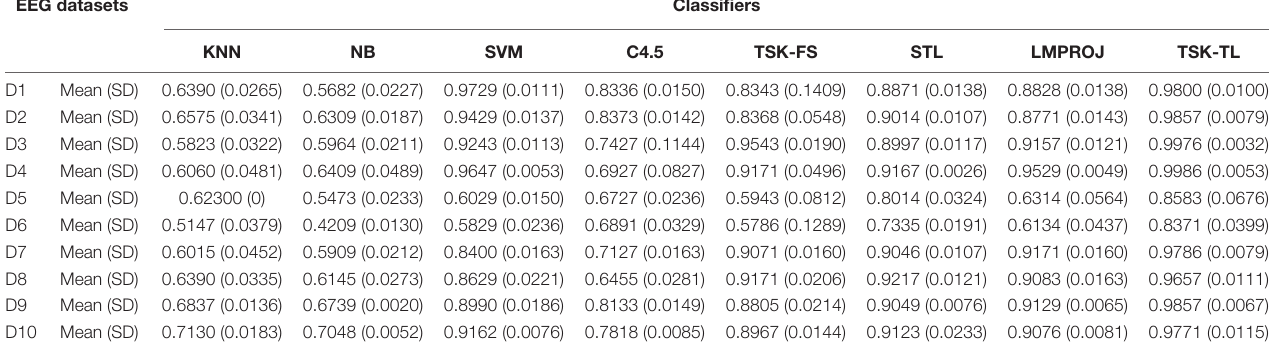
TABLE 6 | Experimental results of eight classifiers in the KPCA